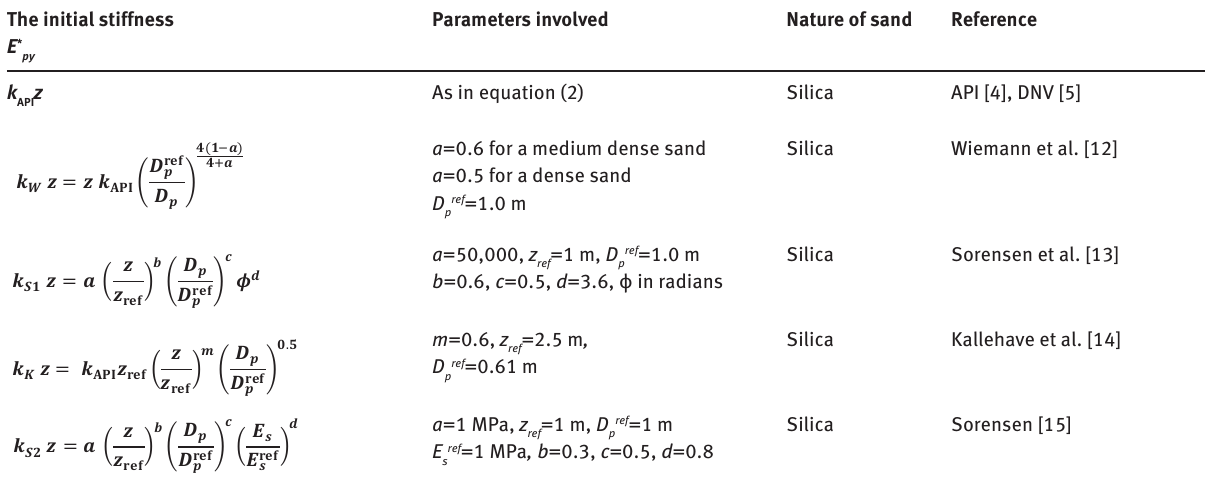
Parameters involved Nature of